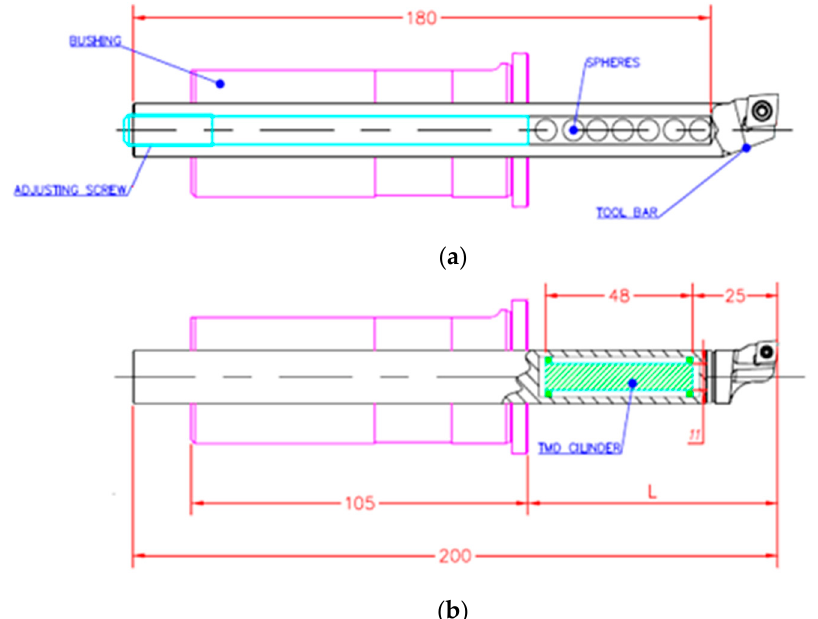
Figure 4. Boring bars in millimeter unit: ( a ) ID boring bar; ( b ) TMD boring bar. At the tip of the ID (impact damper) tool, CBN inserts—code CCGW09T308S01020F 7015 (class ISO H10)—and the Silent tool—TMD (tuned mass damper) with code CCGW 060208S01030F 7015. Both inserts have similar characteristics: with 50% CBN and ceramic phase of Al 2 O 3 + TiCN (Sandvik CC 650), insert grain size 0.3–2.0 μ m with